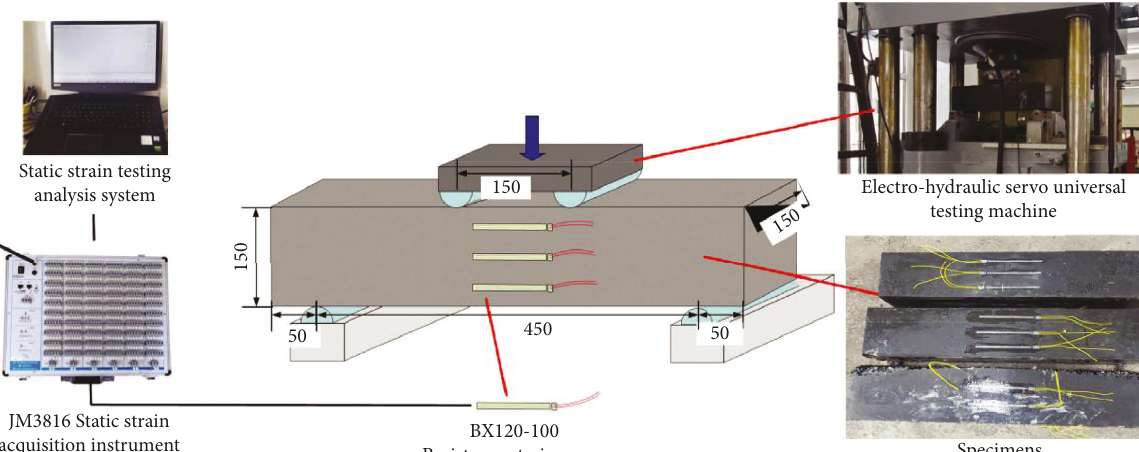
Figure 6: Flexural strength